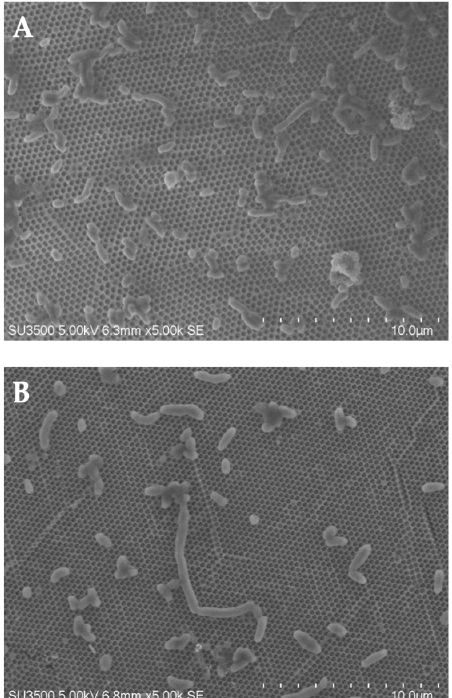
Figure 4. Scanning electron microscopy images of P. phosphoreum after 3 h. ( A ): control. ( B ): AuNPs (10 − 3